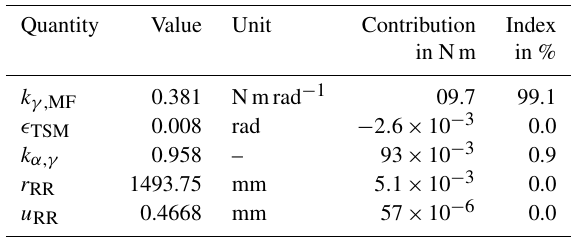
Table 3. Measurement uncertainty budget of TM with a calibration torque moment of 5MNm at the upper MF.